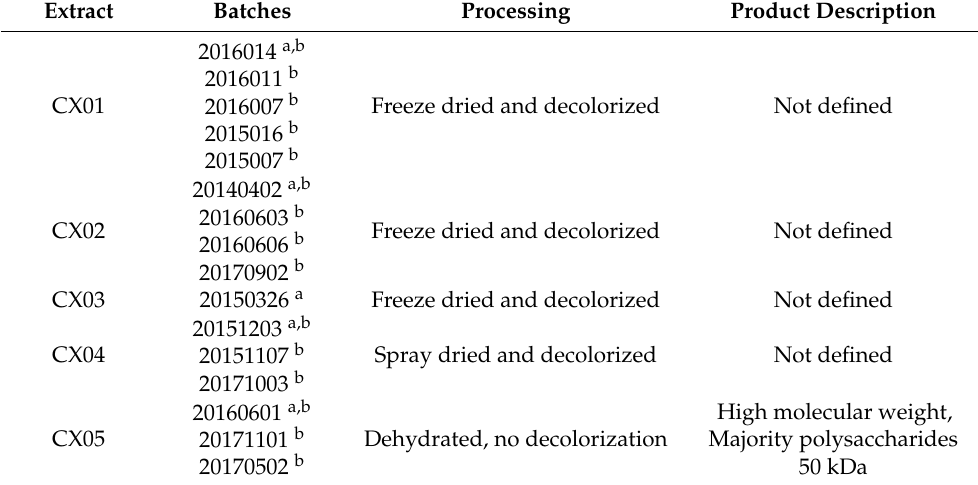
Table 1. Aloe gel extracts analyzed and compared in the study.